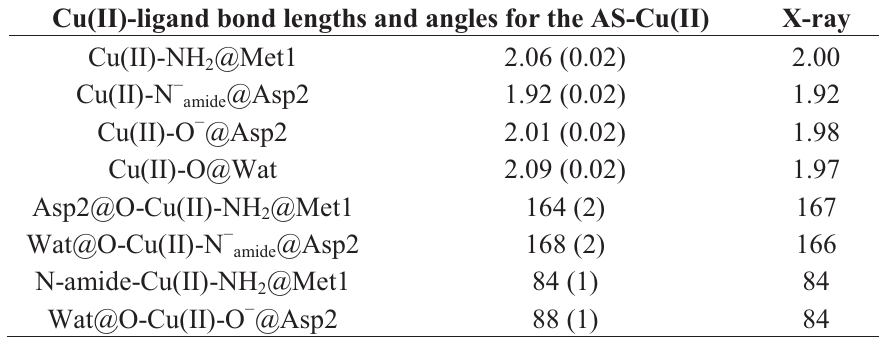
Table 1. Average values of bond lengths (Å) and angles (deg) for the Cu(II)-AS adducts calculated as the weighted average over the QM/MM MD trajectories of the 18 representative conformers. Standard deviations are given in parenthesis. @ refers to the residues to which the coordinating atom belongs. In the last column, the mean bond lengths and angles, obtained from the crystal structures of Cu(II)-peptide adducts, are reported